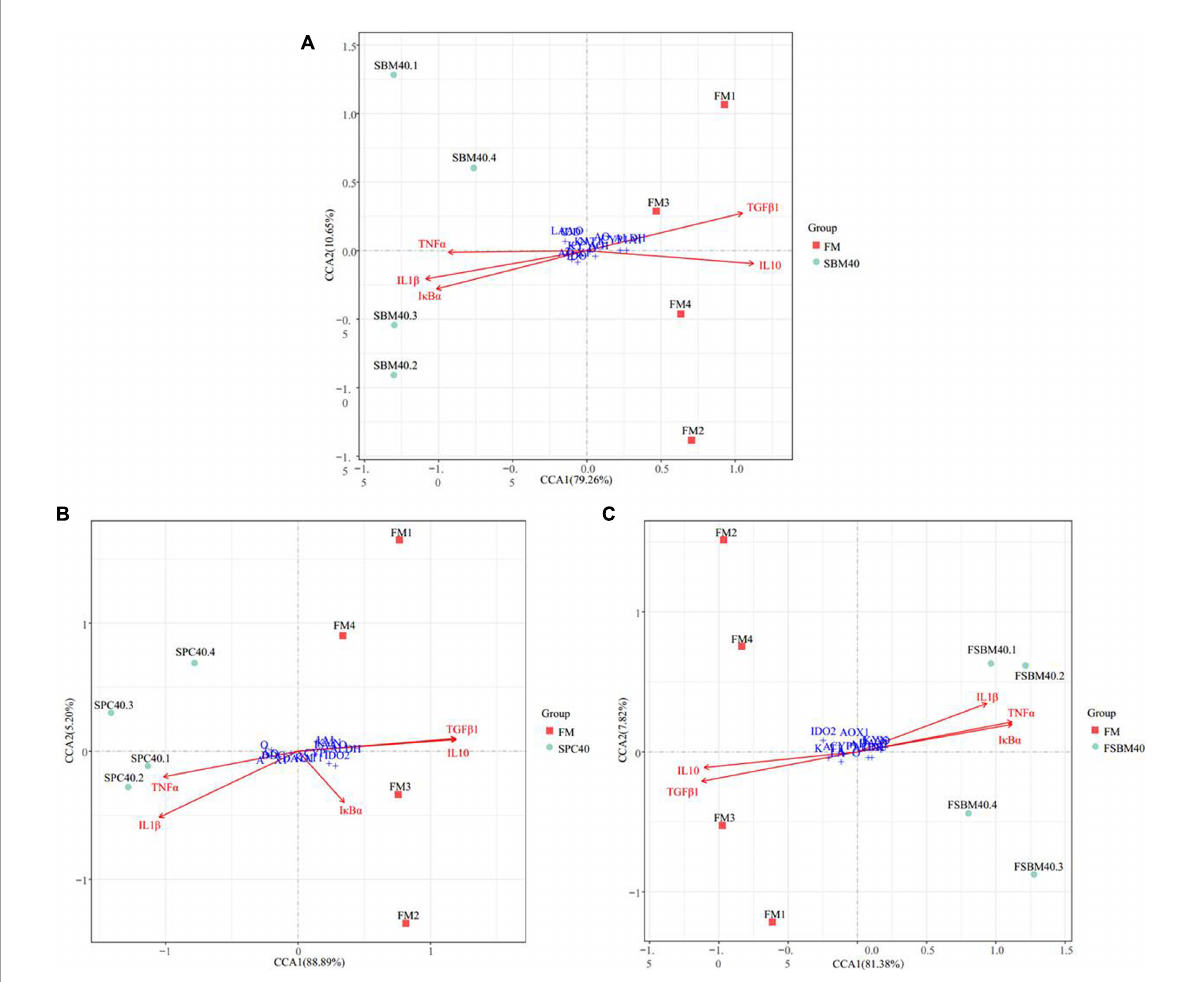
FIGURE7 The canonical correlation analysis (CCA) between the key genes inhibited in tryptophan metabolism pathway and the inflammatory genes of different soy meals induced enteritis in groupers ( n = 4). In CCA plot, the arrows represent explanatory variables and the points represent response variables. The lengths of the arrows represent the strength of the influence of the explanatory variable on the response variable; the longer lengths indicate greater influences. The angles between the arrows and coordinate axis represent the correlation between the explanatory variable and coordinate axis; smaller angles indicate stronger correlation. A sample point located in the same direction as the arrow indicates that the changes in explanatory and response variables are positively correlated, while in the opposite direction which indicates a negative correlation. The value in the coordinate axis label in the plot represents the interpretation proportion of the explanatory variables combination and the response variable variation. FM, fish meal control group; SBM40, 40% SBM substitution for FM; SPC40, 40% SPC substitution for FM; FSBM40, 40% FSBM substitution for